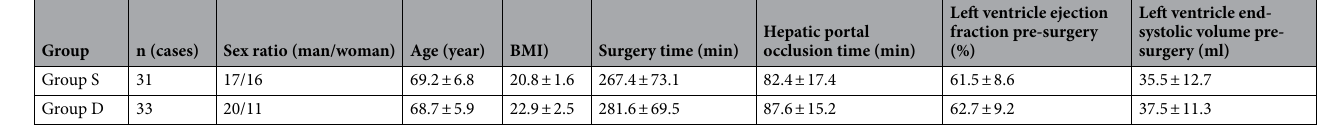
Table 1. Comparison of the general conditions of patients in the two groups ( x ±